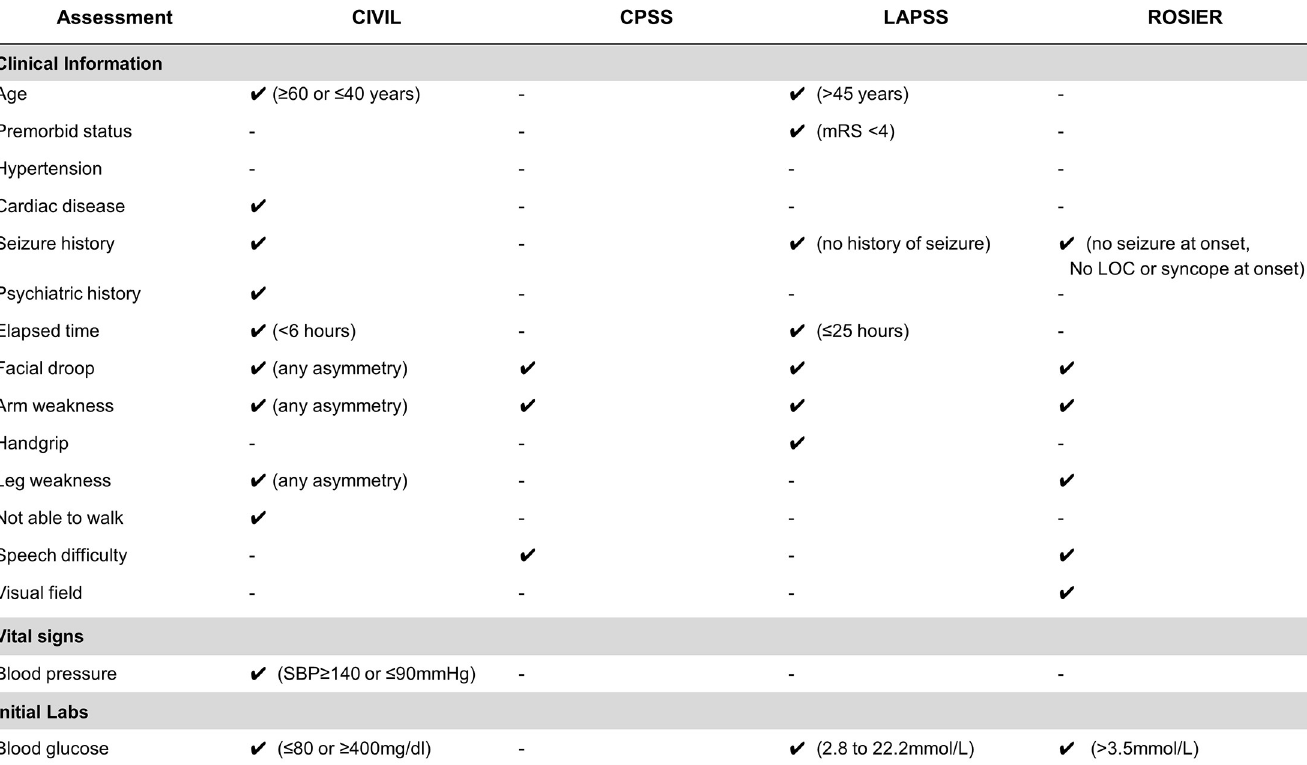
Fig 2. Summary of items and scoring in the CIVIL system. In tier 1 (CIVIL -AS 3 A 2 P ), 7 items which included clinical information (white), vital signs (grey), and initial labs (dark grey) were used. Stroke-preferred items were assigned positive points and stroke mimic preferred items were negative points (ranged from ― 5 to +6). Tier 2 (CIVIL -MAPS ) allocated 4 items with clinical information and vital signs, and the GFAST system was applied in tier 3 (CIVIL -GFAST ) for the selection of ELVO